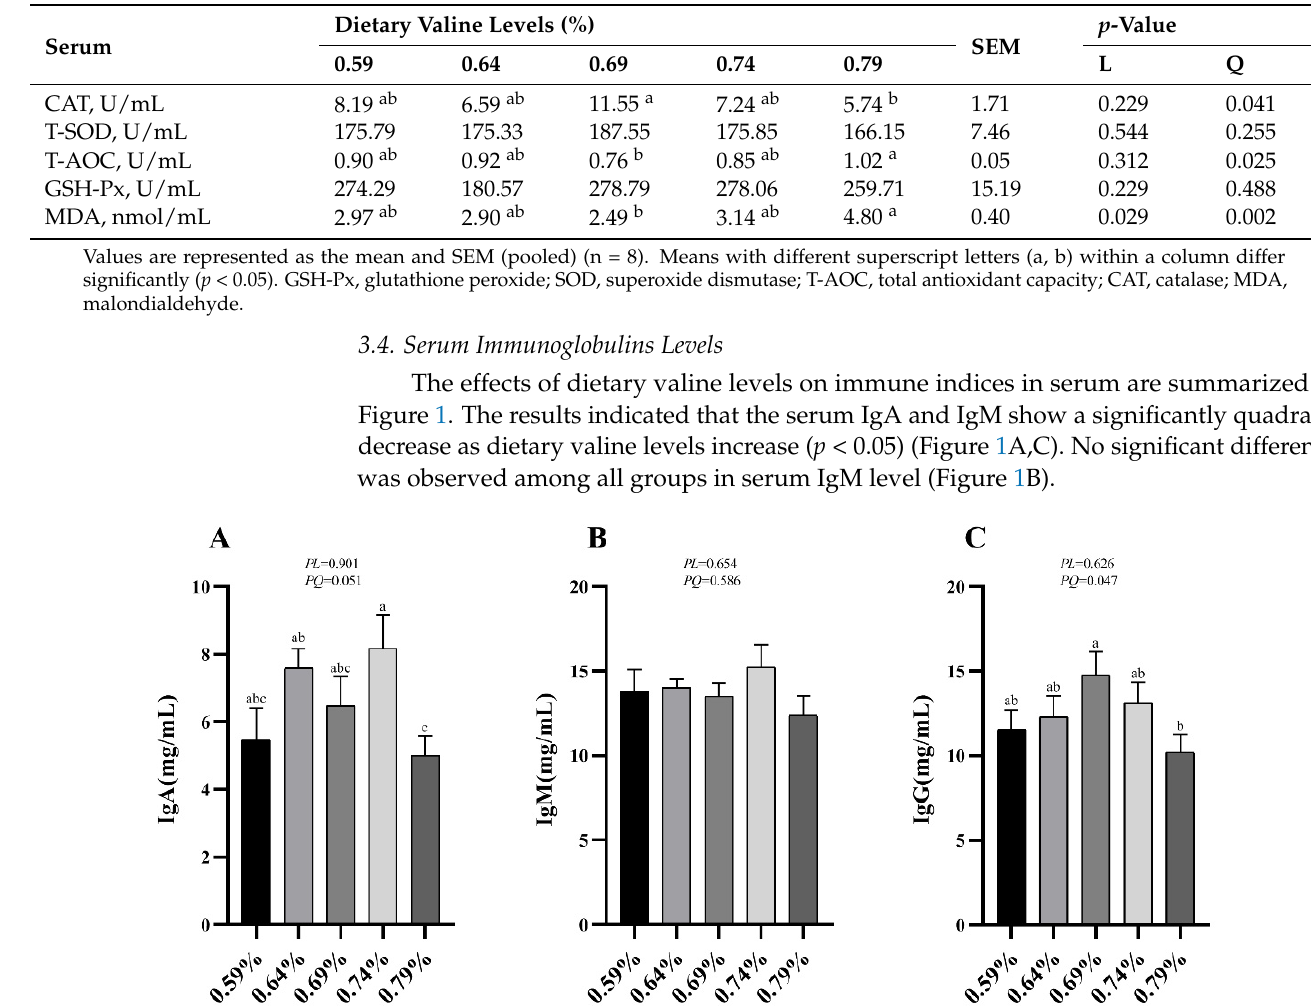
Table 5. Effects of dietary valine levels on serum antioxidant capacity of laying hens.